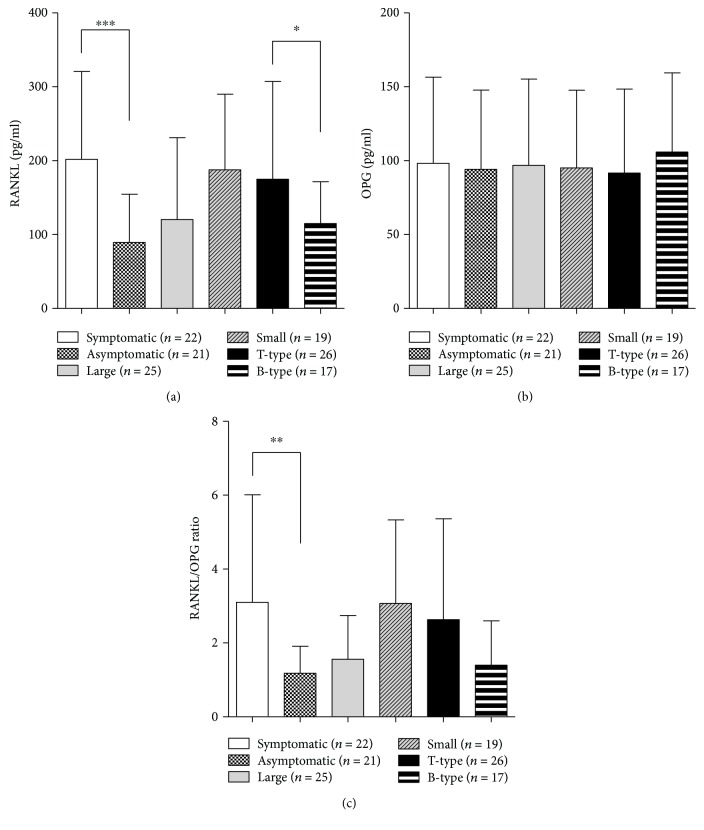
The levels of RANKL (a), OPG (b), and values of RANKL/OPG ratio (c) in PL cell cultures in relation to clinical characteristics of the lesions and T/B cell predominance. Periapical lesion (PL) cells were isolated from 43 PLs and cultivated for 24 hours as described in “Materials and Methods.” The levels of soluble RANKL and OPG in supernatants were measured by ELISA, and after that, the RANKL/OPG ratio was calculated. The differences between groups were tested by using the pair Student t-test. The statistically significant difference was marked on the graph. ∗p < 0.05, ∗∗p < 0.01, and ∗∗∗p < 0.001, as indicated.